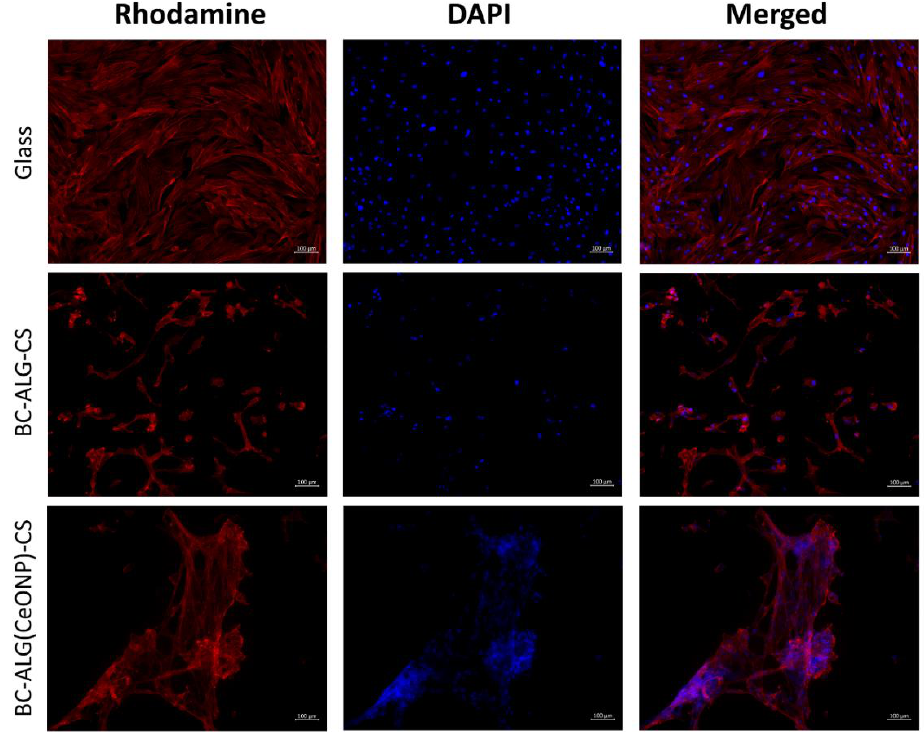
Figure 9. Multipotent mesenchymal stem cells adhered to the surfaces of glass and scaffolds. Fibrillar actin of the cytoskeleton was stained with rhodamine fluorochrome; nuclei were stained with DAPI. Combined two-channel image, magnification ×100.